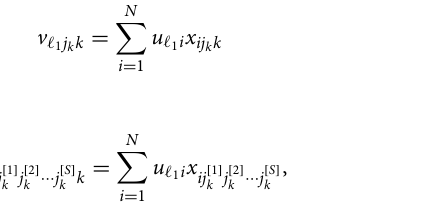
, ∈ R N × M k representing expression of the i th gene at the j k